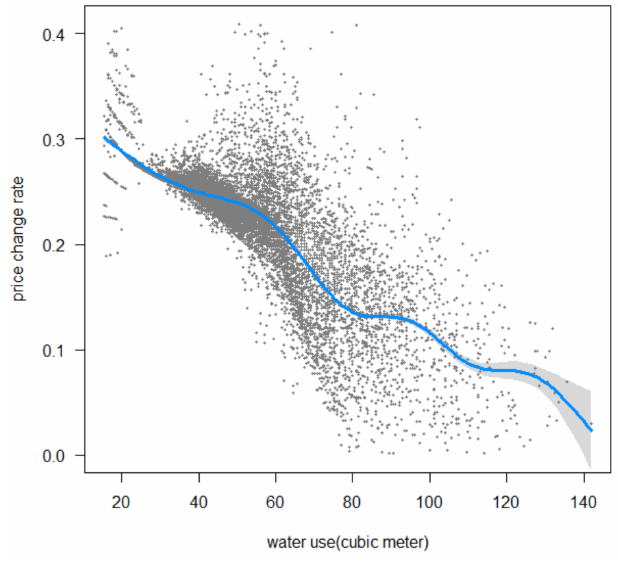
Figure 1. Scatterplot of water use and price change rate (Price